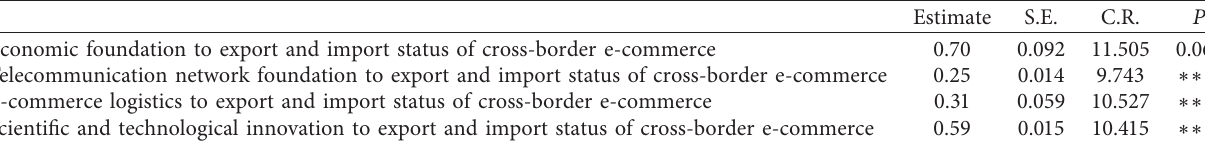
Figure 2: Path coefficient Table 4: Path coefficients and their degree of confidence.